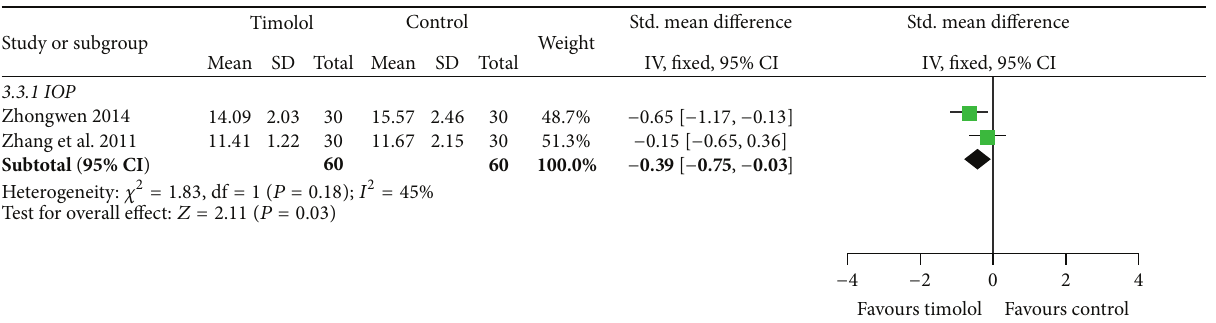
Figure 5: Intraocular pressure in timolol and controls